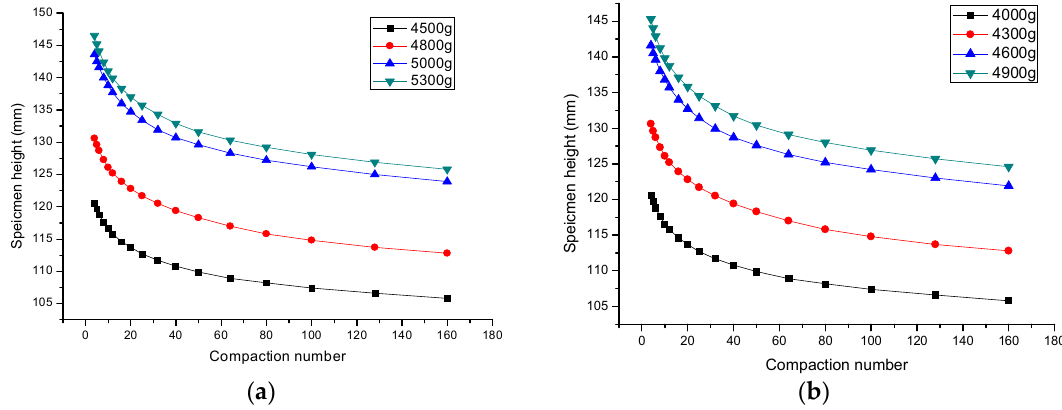
Figure 5. Compaction curves of ( a ) Aggregate A and ( b ) Aggregate B of different mixture weights.